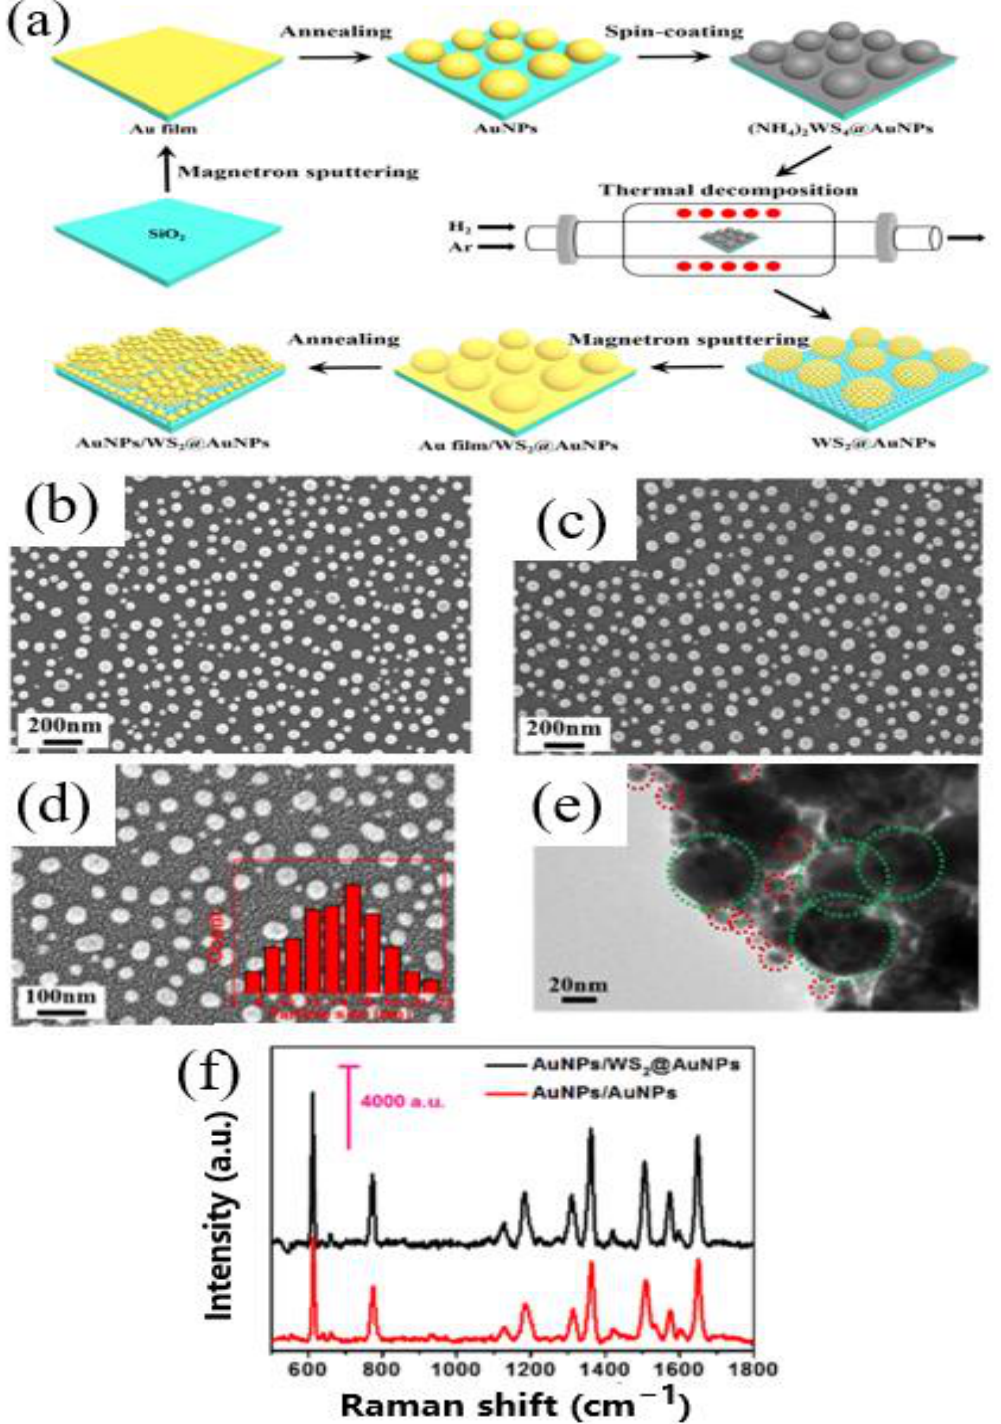
Figure 11. ( a ) Schematic illustration of synthetic process of Au NPs/WS 2 @Au NPs hybrids. ( b , c ) SEM images of the Au NPs generated from annealing thin Au film and WS 2 @Au NPs composites. ( d ) SEM images of Au NPs/WS 2 @Au NPs. The inset pattern showed the size distribution of small Au NPs achieved through the annealing process of 3 nm Au film. ( e ) TEM image of the Au NPs/WS 2 @Au NPs composites. The green and red dotted circles label the outline of Au NPs with different average diameters, respectively. ( f ) SERS spectra of R6G with a concentration of 10 −5 M were collected from Au NPs/WS 2 @Au NPs and Au NPs/Au NPs substrates. Reprinted from Ref. [124] with permission of 2018 Optical Society of America.